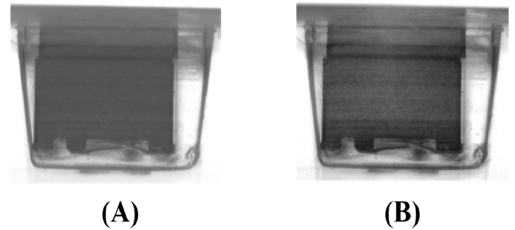
Figure 12. CLAHE-applied example.